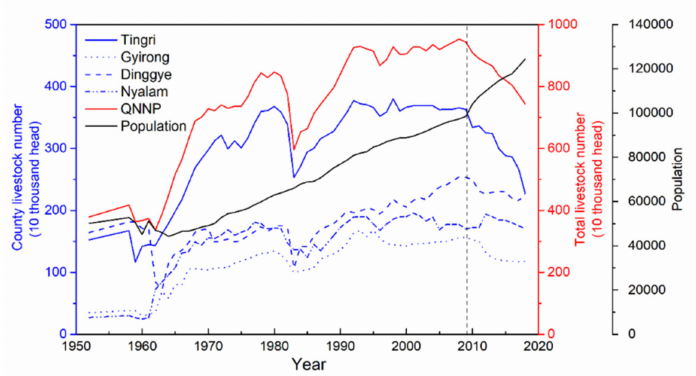
Figure 11. Livestock numbers in the QNNP and four counties during 1952–2018. The red line denotes the total livestock numbers of the four counties. The vertical dashed line (2009) depicts time when a large fluctuation in the number of livestock occurred in the